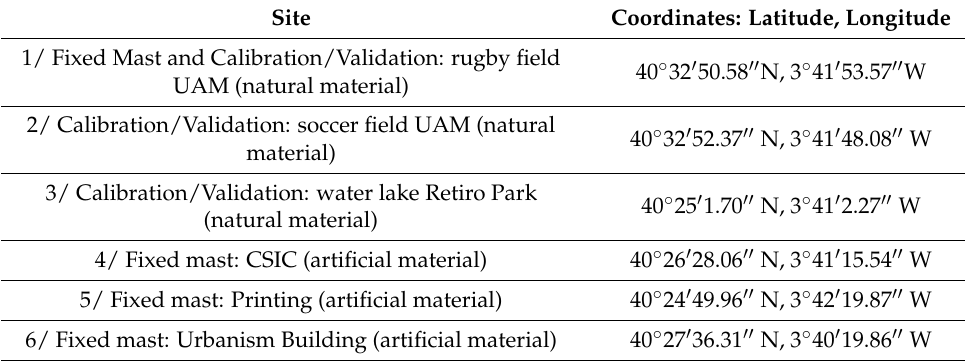
Figure 1. RGB AHS image for the 4 of July of 2008. Yellow squares highlight the two areas used for visual analysis: the Retiro Park in the center of Madrid and the Universidad Autonoma de Madrid (UAM) in the peri-urban northern area of the city. North is marked by the arrow. The green square highlights the rural area, and the purple square highlights the urban area; both areas were chosen to compute the SUHI. Green stars point out the locations of ground measurements from calibration/validation sites or from fixed masts, with numbers in correspondence with Table 2. Table 2. Names and locations of the calibration/validation sites and fixed